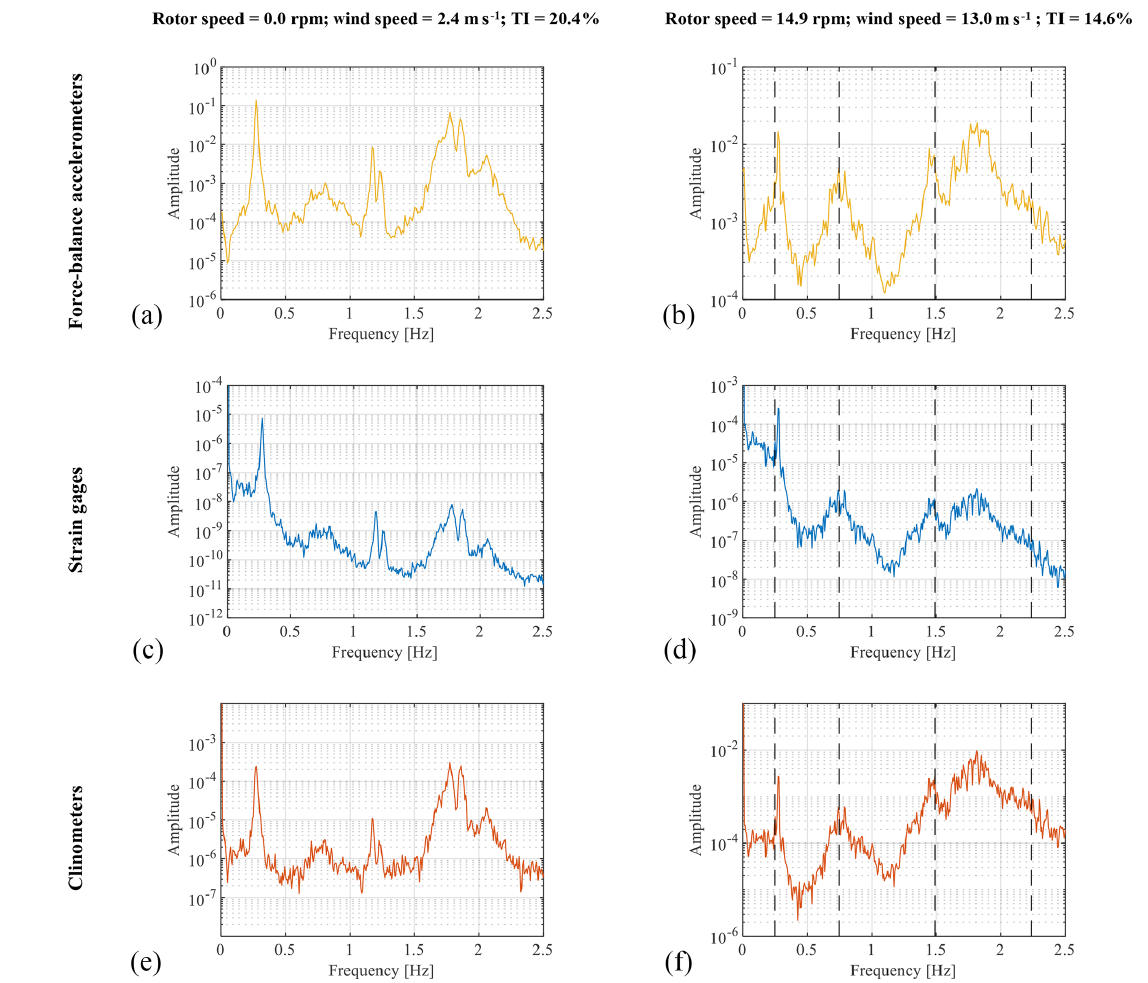
Figure 14. Averaged power spectra: longitudinal strains A to D (a, b) and rotation at clinometer 3 (c, d) in non-operating condition (a, c, e) and operating condition (b, d, f)